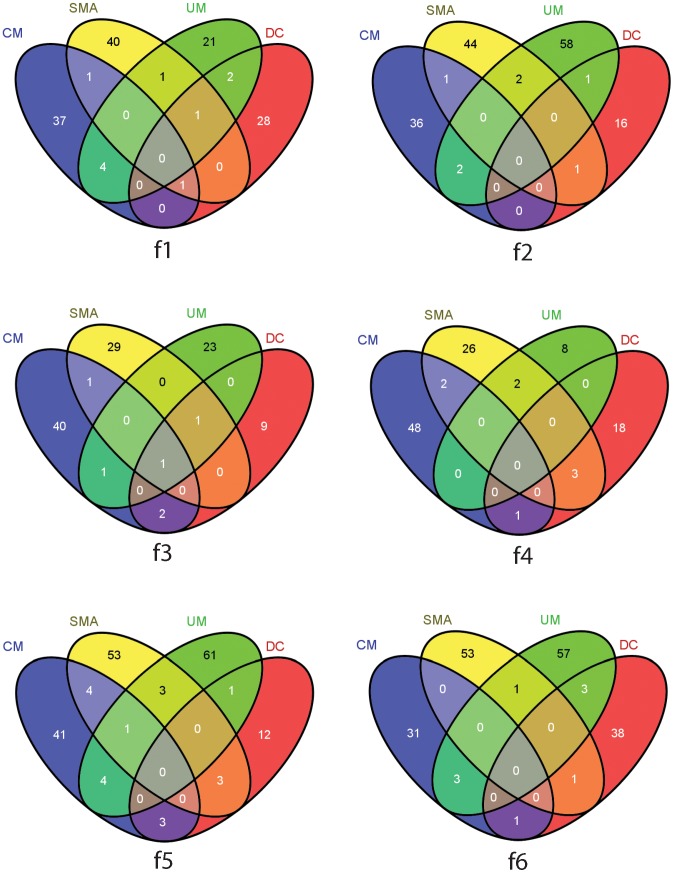
Proteome-pattern overlap.The Venn diagram represents the level of overlap between the patterns that individually discriminate CM, SMA, UM and DC from CC. CM = Cerebral Malaria; SMA = Severe Malarial Anemia; UM = Uncomplicated Malaria. f1 to f6 represent anionic plasma fractions at pH 9.0 (f1), pH 7.0 (f2), pH 5.0 (f3), pH 4.0 (f4), pH 3.0 (f5) and organic phase (f6).